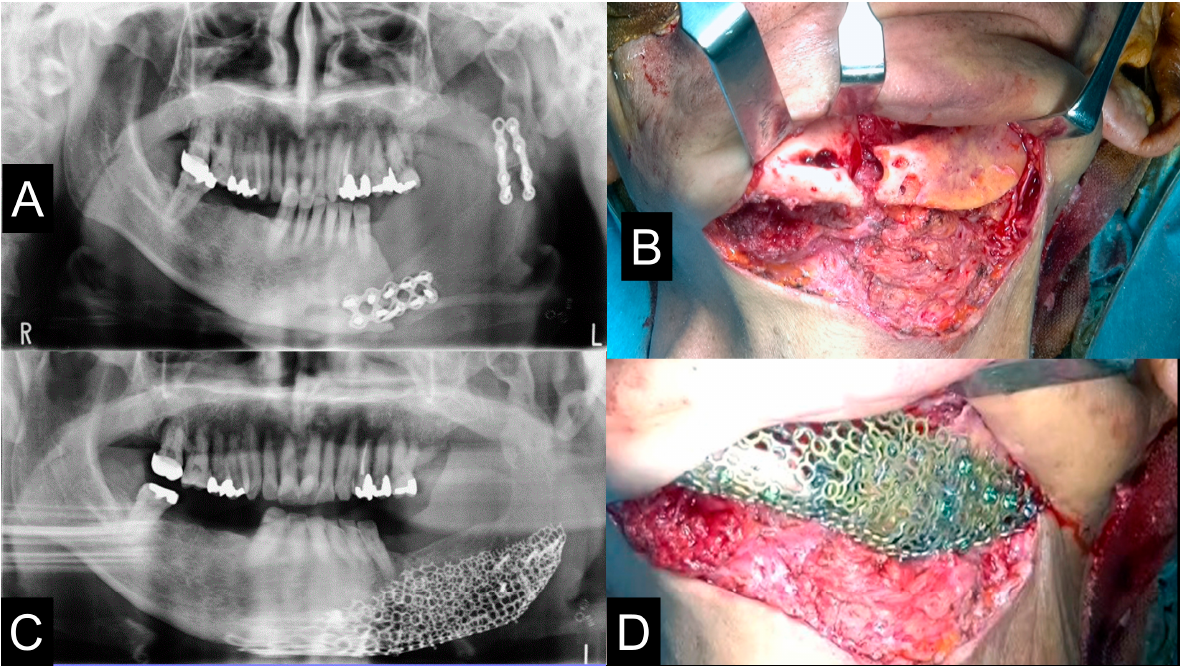
Figure 13. Pre- and postoperative panoramic radiographs showed accurate jaw reconstruction. ( A , C ). The patient’s pre-bended custom-made TiMesh was fixed with a positioning device and a PCBM was grafted ( B , D ). After the operation, the mandibular deviation was corrected and the dental occlusion was improved. A removal conventional partial denture was applied for occlusal rehabilitation. The left dislocated condyle did not show any clinical symptoms with ipsilateral